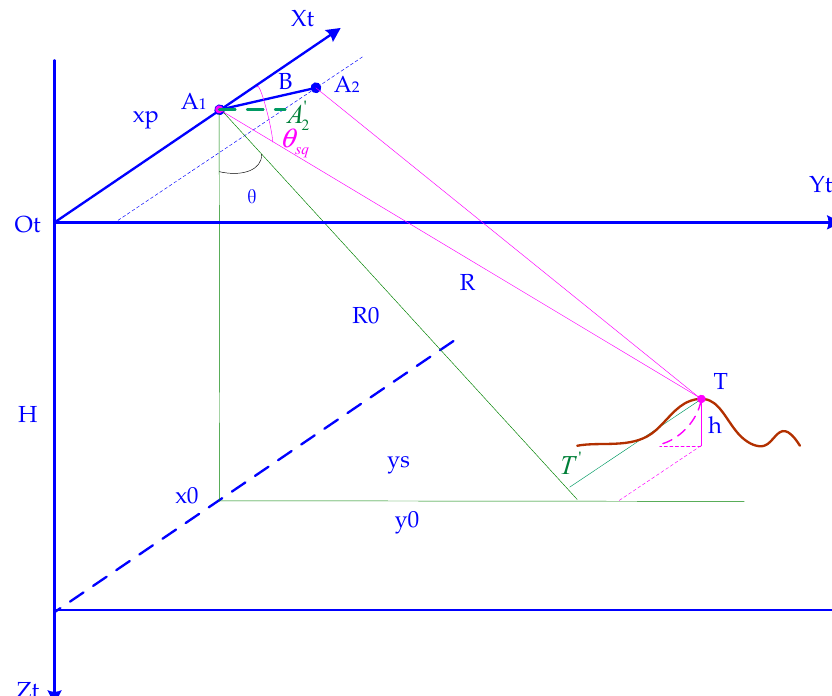
Figure 1. InSAR geometric model in ideal airframe coordinate system.